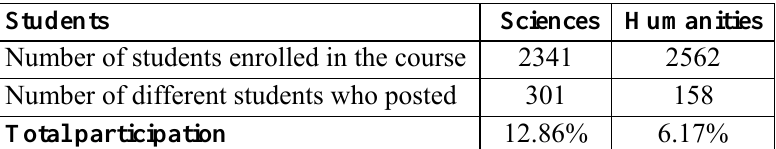
Number and Percentage of Students who Posted Messages Students